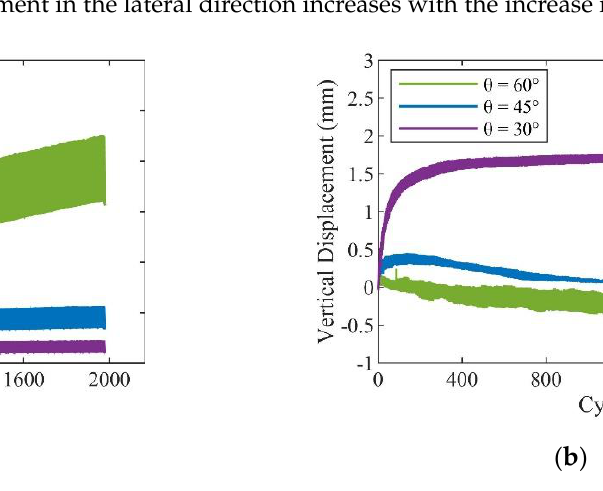
Figure 8. Time history of displacement of cyclic loading with variable initial tension angles: ( a ) lateral, ( b ) vertical.